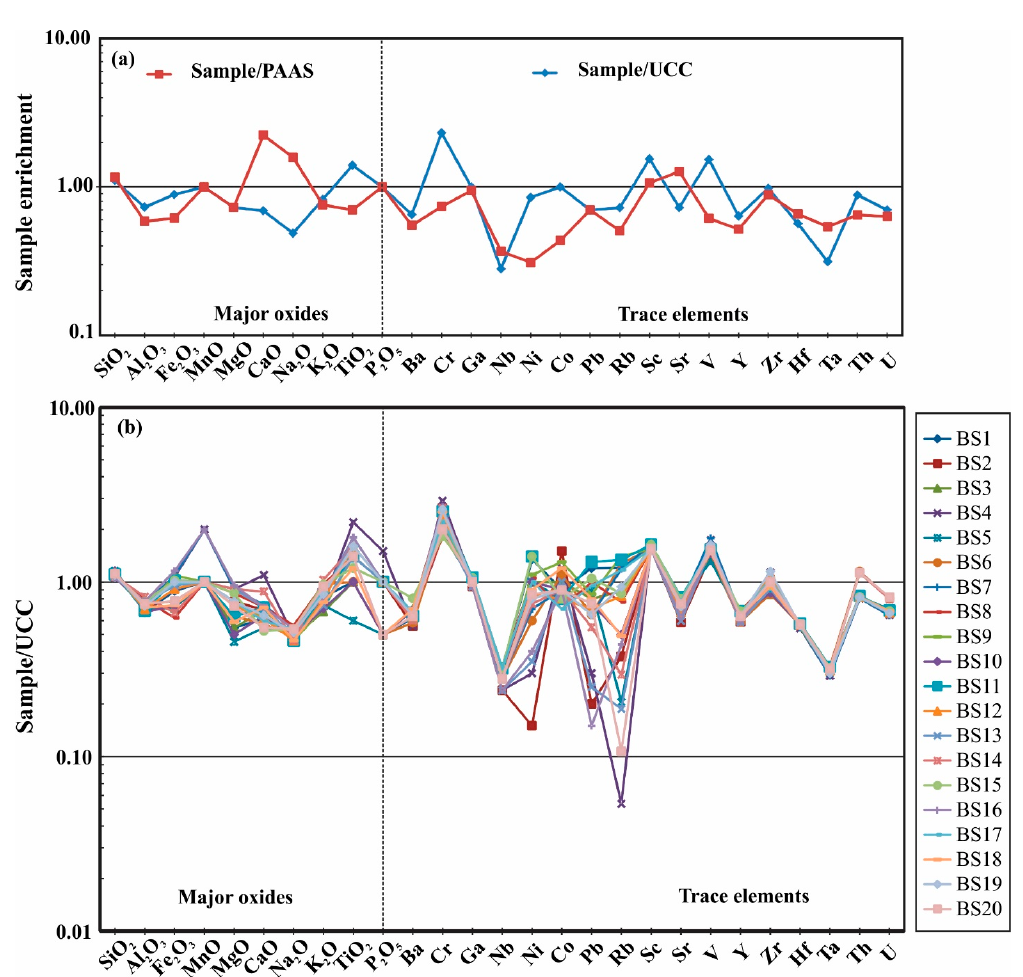
Figure 2. Plots comparing ( a ) the abundance for the average major oxide (in wt.%) and trace element compositions (in ppm) of the Brahmaputra River samples normalized against data for Post ‐ Archean Australian Shale (PAAS) and Upper Continental Crust (UCC) and ( b ) multi ‐ element diagram for individual Brahmaputra River sediment samples, normalized against average upper continental crust (UCC) compositions.